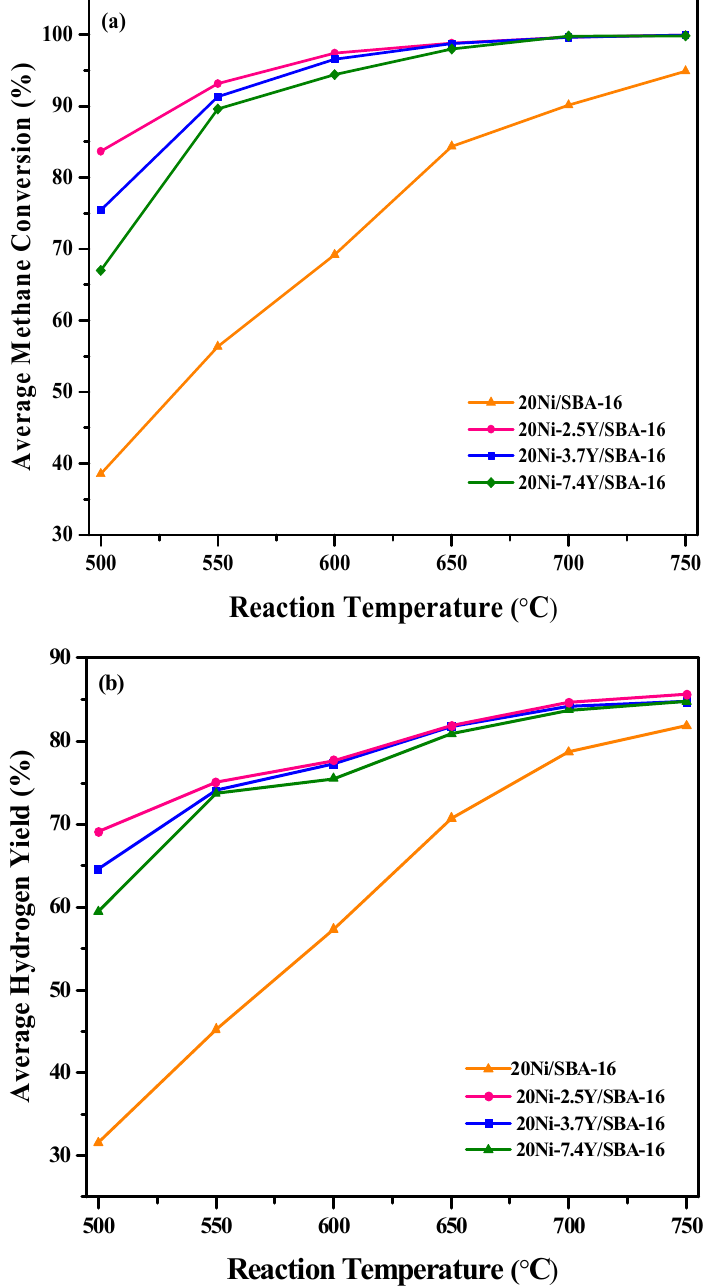
Figure 5. The effect of Y weight percentage and different reduction temperature on ( a ) Average methane conversion and ( b ) Average hydrogen yield of 20Ni ‐ yY/SBA ‐ 16 oxygen carriers.